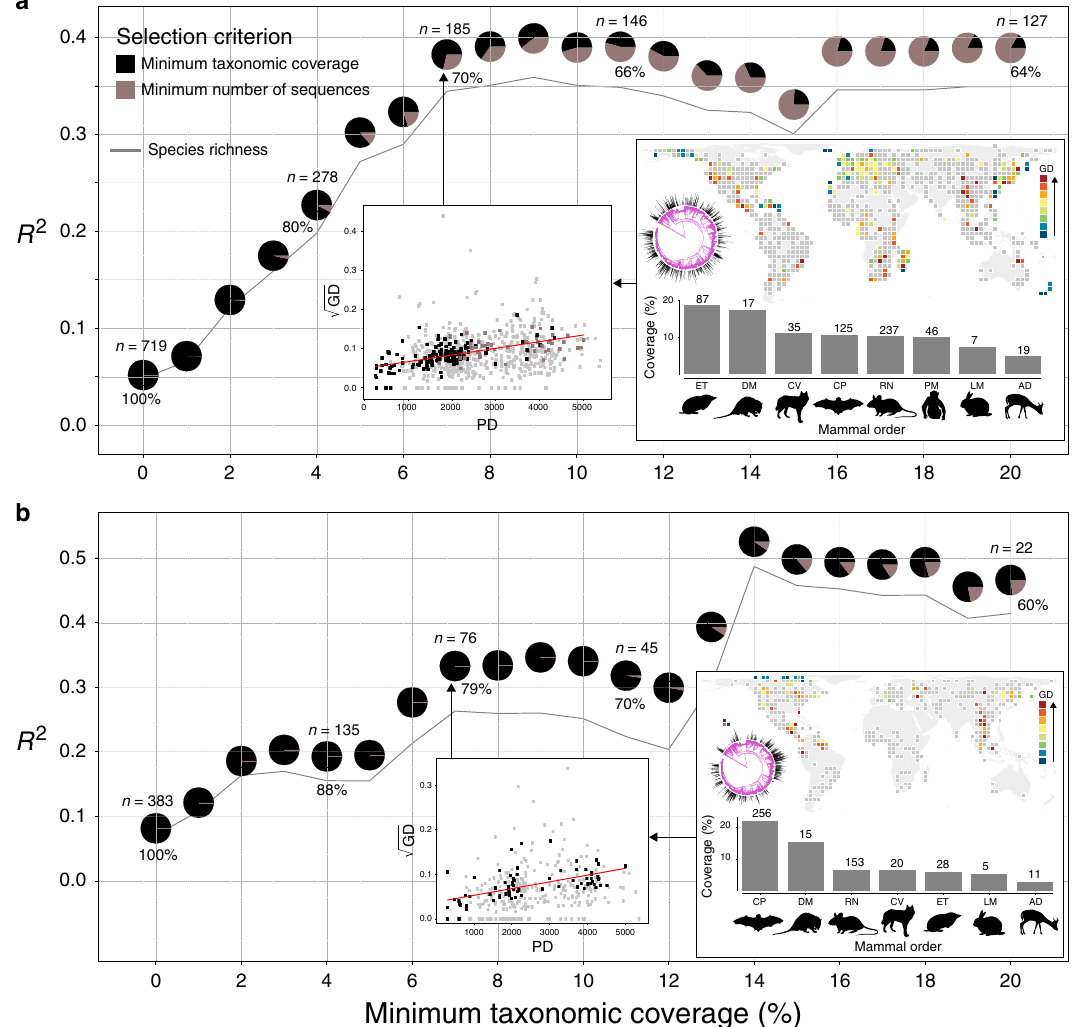
Fig. 2 Correlation between biodiversity dimensions and genetic diversity at the grid cell scale. Correlation ( R 2 ) between genetic diversity (GD; average number of mutations per base pair) and phylogenetic diversity (PD; millions of years; pies) and species richness (SR; number of species; grey line) for cytb ( a ) and co1 ( b ) across subsets of data when grid cells with low taxonomic coverage and sequence availability are excluded (only cells with a minimum of 55 sequences for cytb and 278 sequences for co1 were retained; see Methods; see also Supplementary Tables 3 and 4 for modi fi ed t -tests of spatial association). The numbers above and below pies represent the number of retained cells ( n ) and the percentage of retained sequences relative to the full dataset, respectively. Colours in each pie (black and brown) represent the proportion of grid cells that follow each of the selection criteria relative to the total number of retained cells. The inset scatterplot shows the relationship between PD and the square root of GD (grey squares show the full dataset), the map shows the distribution of cells, black lines on the mammalian phylogenetic trees show the retained sequence number (log transformed) per species, and bars show the mammalian order coverage (orders with fi ve or more retained species; retained species numbers on top of the bars). Order abbreviations: AD Artiodactyla, CV Carnivora, CP Chiroptera, DM Didelphimorphia, ET Eulipotyphla, LM Lagomorpha, PM Primates, RN